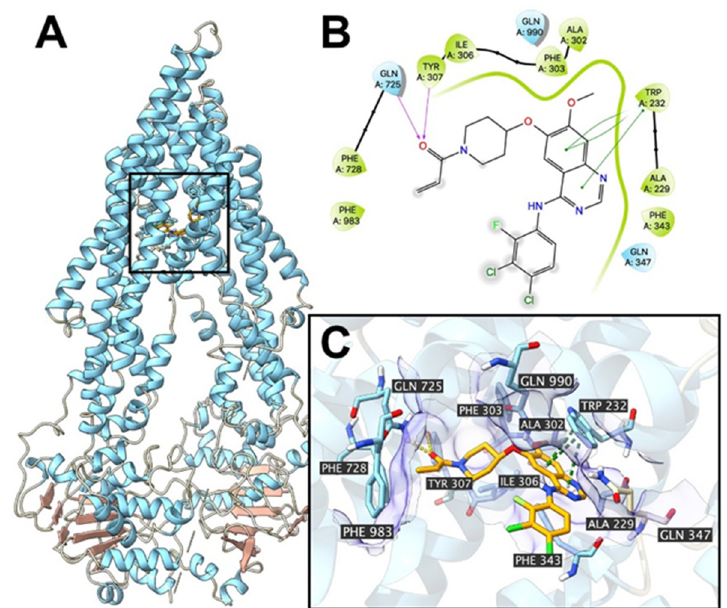
Figure 10. The interaction between poziotinib and human ABCB1 protein model. ( A ) An overview of the best-scoring pose for poziotinib in the drug-substrate binding site of the ABCB1 transporter protein (6QEX). ABCB1 is displayed as colored ribbons (helix: blue; strand: red; coil: white). Poziotinib was displayed as colored sticks. ( B ) A 2D diagram of the interactions between poziotinib and ABCB1. Amino acids within 3 Å from the ligand are displayed as colored bubbles (green: hydrophobic; blue: polar). Purple solid lines with arrows indicate hydrogen bonds. Green solid lines without arrows indicate π - π stacking interactions. ( C ) Details of interactions between poziotinib and the ABCB1 (6QEX) drug-substrate binding site. ABCB1 helices are displayed as colored ribbons. The important residues are displayed as colored sticks (carbon: orange; oxygen: red; nitrogen: blue; hydrogen: white; fluoride: lime; chloride: light green). The surface formed by the important residues are depicted as purple solid planes. Poziotinib are displayed as colored sticks (carbon: orange; oxygen: red; nitrogen: blue; chloride: lime; fluoride: light green).